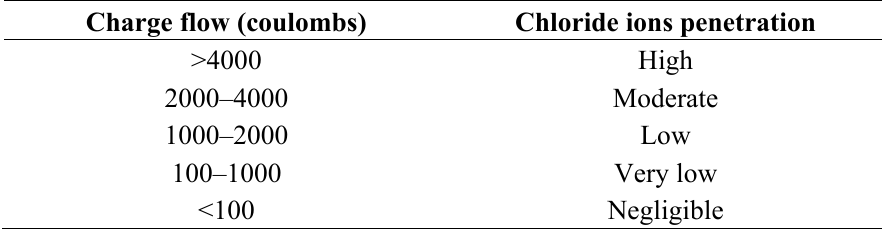
Table 3. Classification criteria for chloride diffusion, ASTM C1202